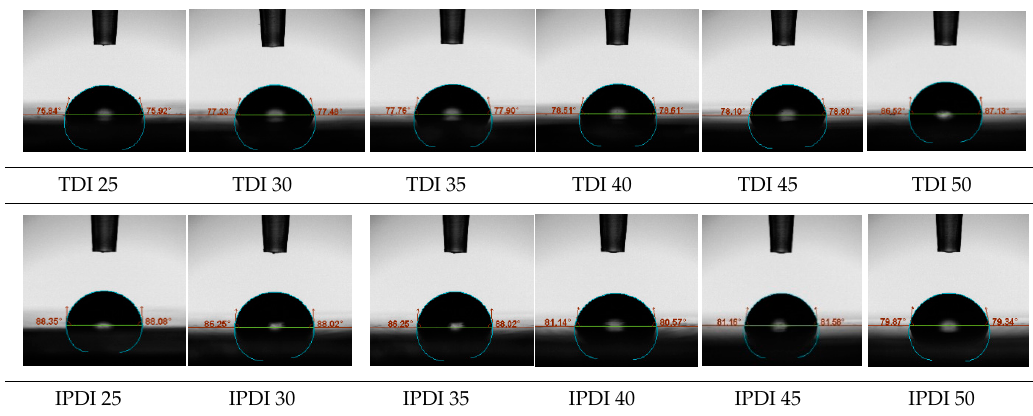
Table 7. Contact angle measurement of JPUA-TDI and JPUA-IPDI-based coatings.